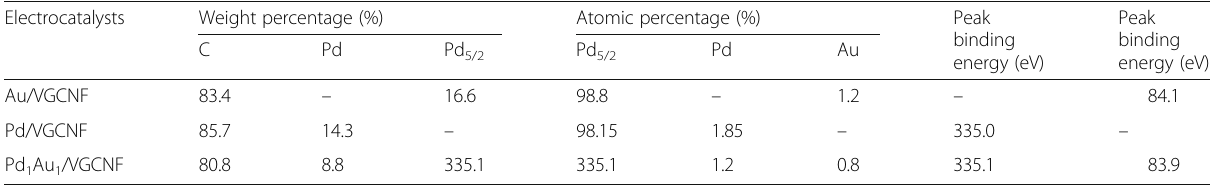
Table 2 Quantitative results carbon (C), palladium (Pd), and aurum (Au) elements on the surface of the electrocatalysts and binding energy from XPS analysis Electrocatalysts